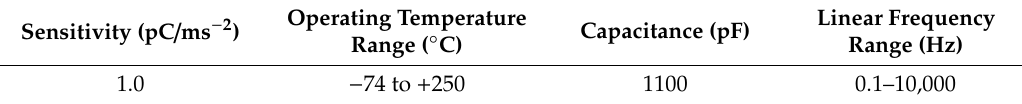
Table 4. Specifications of piezoelectric charge